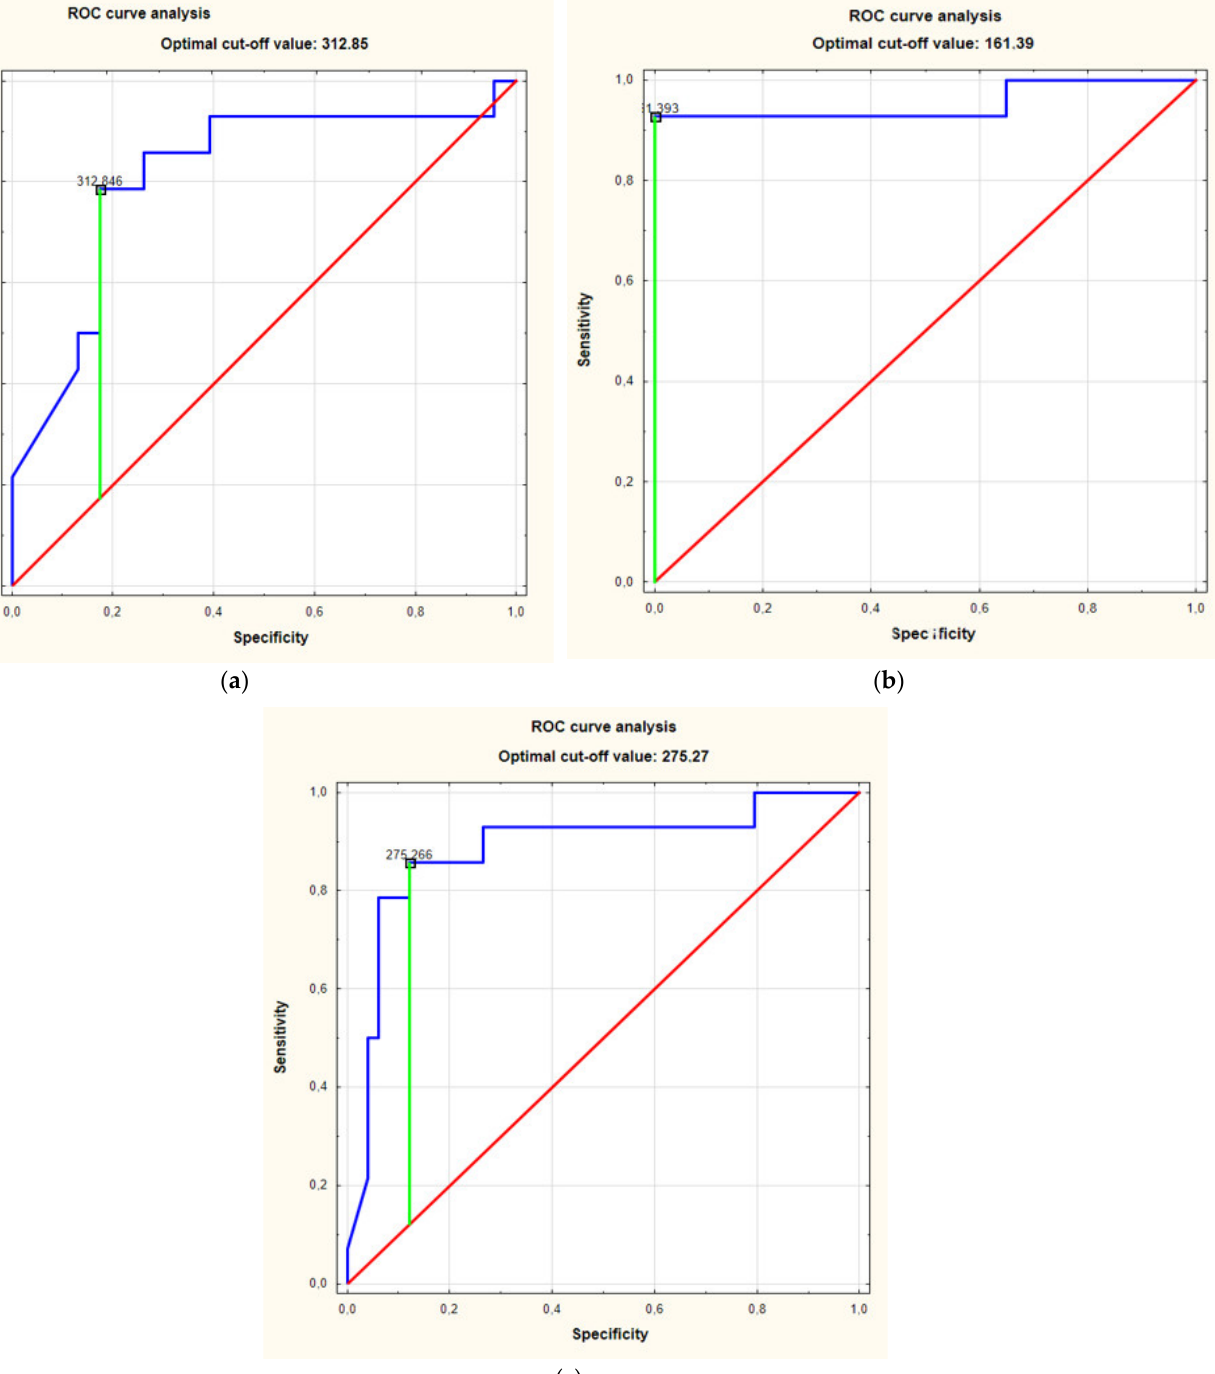
Figure 4. ( a ). ROC curve analsysis of relationship between serum concentrations of S100A15 in individuals with HS in stage Hurley III and controls showed area under the curve (AUC) of 0.81. (95%CI for AUC: 0.66–0.97) ( p = 0.0001). ( b ). ROC curves analysis of relationship between serum concentrations of S100A15 in individuals with HS in Hurley III stage and in individuals with HS in Hurley I stage revealed AUC of 0.95 (95%CI for AUC: 0.86–1) ( p < 0.0001). ( c ). ROC curves analysis of relationship between serum concentrations of S100A15 in individuals with HS in Hurley III stage and in individuals with HS in less severe stages (Hurely I, Hurley II) revealed AUC of 0.88 (95%CI for AUC: 0.77–0.99) ( p < 0.0001). The serum concentrations of S100A15 in the individuals with HS in Hurley stage III were significantly increased compared to those of the individuals with HS in Hurley stage I and the individuals with HS in Hurley stage II ( p < 0.0001 and p = 0.0004, respectively) (Figure 3b). The ROC curve analysis of the relationship between the serum concentration of S100A15 in the individuals with HS in Hurley stage III and in the individuals with HS in Hurley stage I revealed an AUC of 0.95 (95%CI for AUC: 0.86–1) ( p < 0.0001). The opti- mal cut-off value was 161.39 pg/mL (Figure 4b). The ROC curve analysis of the relationship between the serum concentration of S100A15 in the individuals with HS in Hurley stage III and in the individuals with HS in the less severe stages (Hurley I and Hurley II) revealed an AUC of 0.88 (95%CI for AUC: 0.77–0.99) ( p < 0.0001). The optimal cut-off value was 275.27 pg/mL. The serum concentration of S100A15 in the individuals with HS was positively cor- related with their CRP concentration ( p = 0.004, R = 0.425) (Figure 5). We did not find any correlations between the serum concentrations of S100A15 and BMI, smoking habit or other demographic and clinical data.